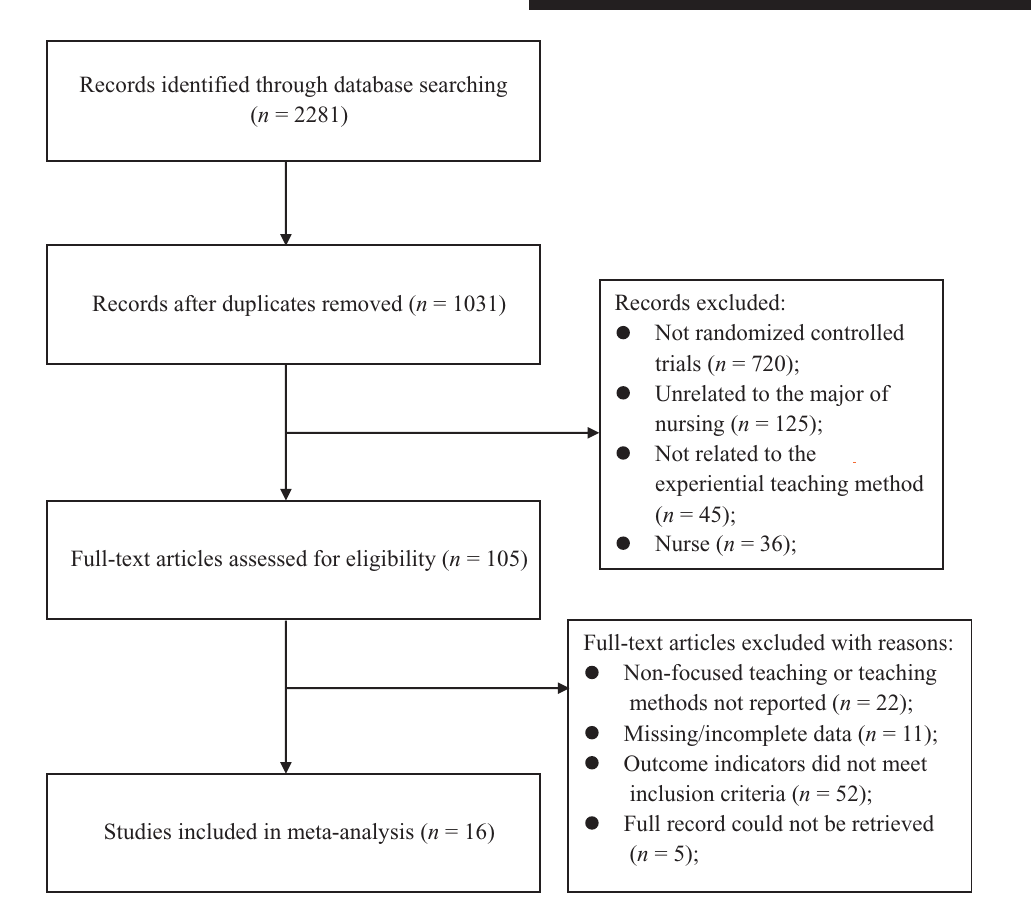
Figure 1. Flowchart of the literature